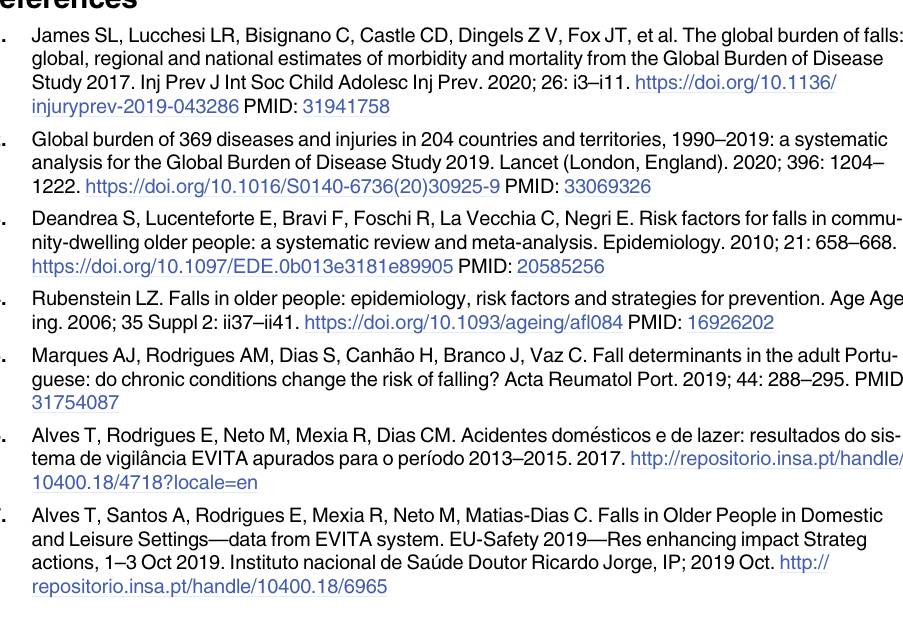
S1 Table. Distribution of rates of falls based on patients and admissions related to falls, between 2010 and 2018, in the Portuguese population. S2 Table. Distribution of number of patients and inpatient admissions related to falls, between 2010 and 2018, in the Portuguese